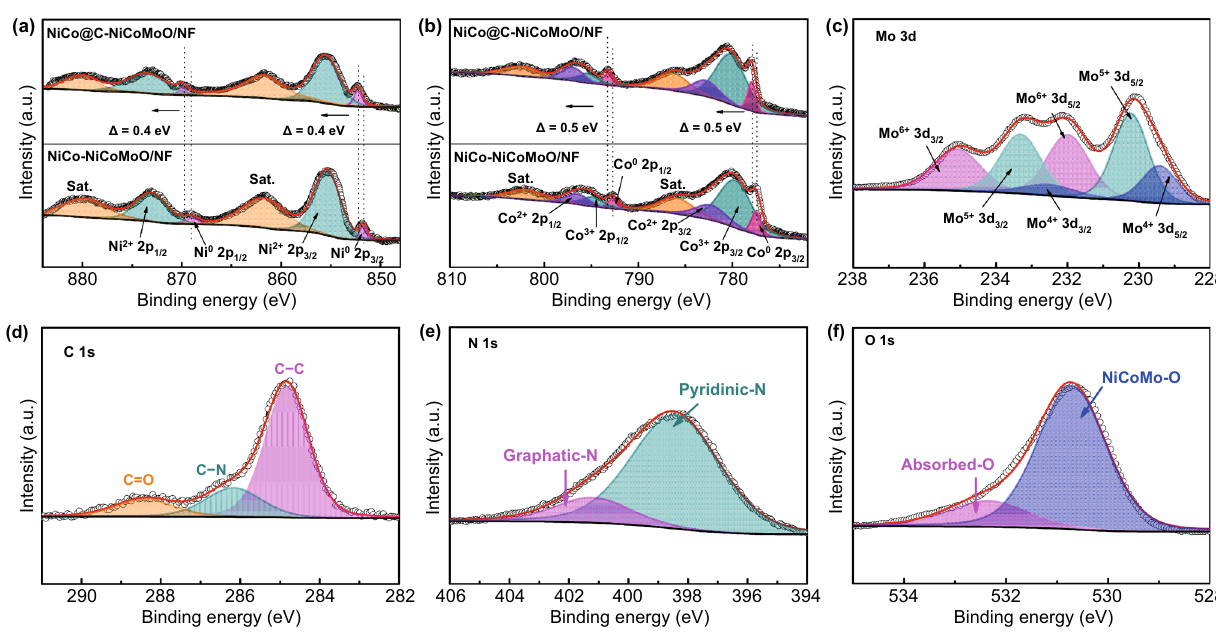
Fig. 3 a , b High-resolution XPS spectra of Ni 2 p and Co 2 p for NiCo@C-NiCoMoO/NF and NiCo-NiCoMoO/NF. c Mo 3 d , d C 1 s , e N 1 s , and f O 1 s of